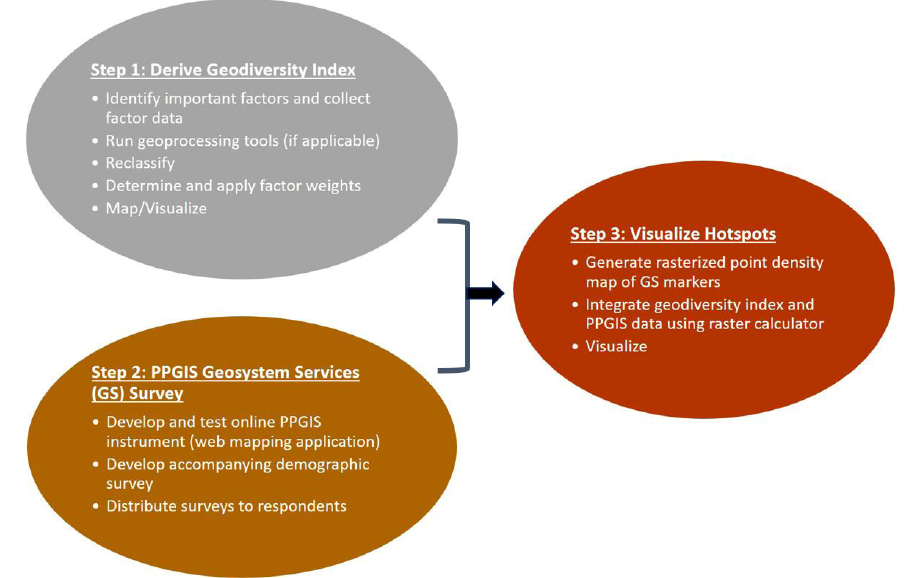
Figure 2. Flow chart depicting major steps of the methodology.